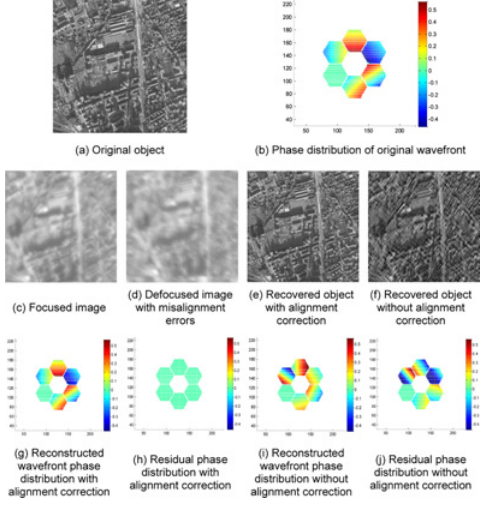
Fig 10. Experimental results of a satellite map of urban scene.